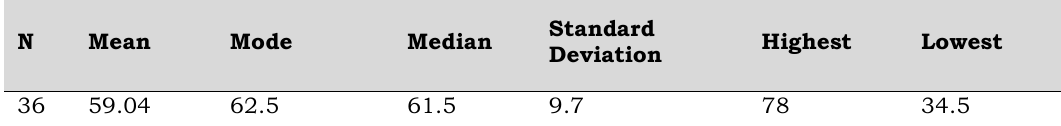
Table 8. The scores of t he low creative students’ writing in control